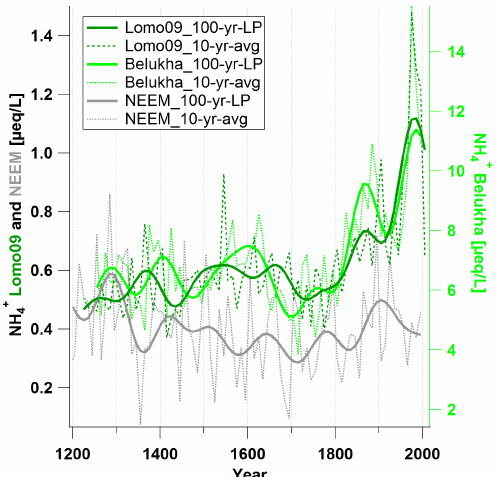
Figure 7. NH + records of the Lomo09 (green), Belukha (light 4 green; Eichler et al., 2009), and the NEEM (grey; Zennaro et al., 2014) ice cores. Bold lines are 100-year lowpass-filtered (100-yr- LP); dashed lines are the 10-year averages